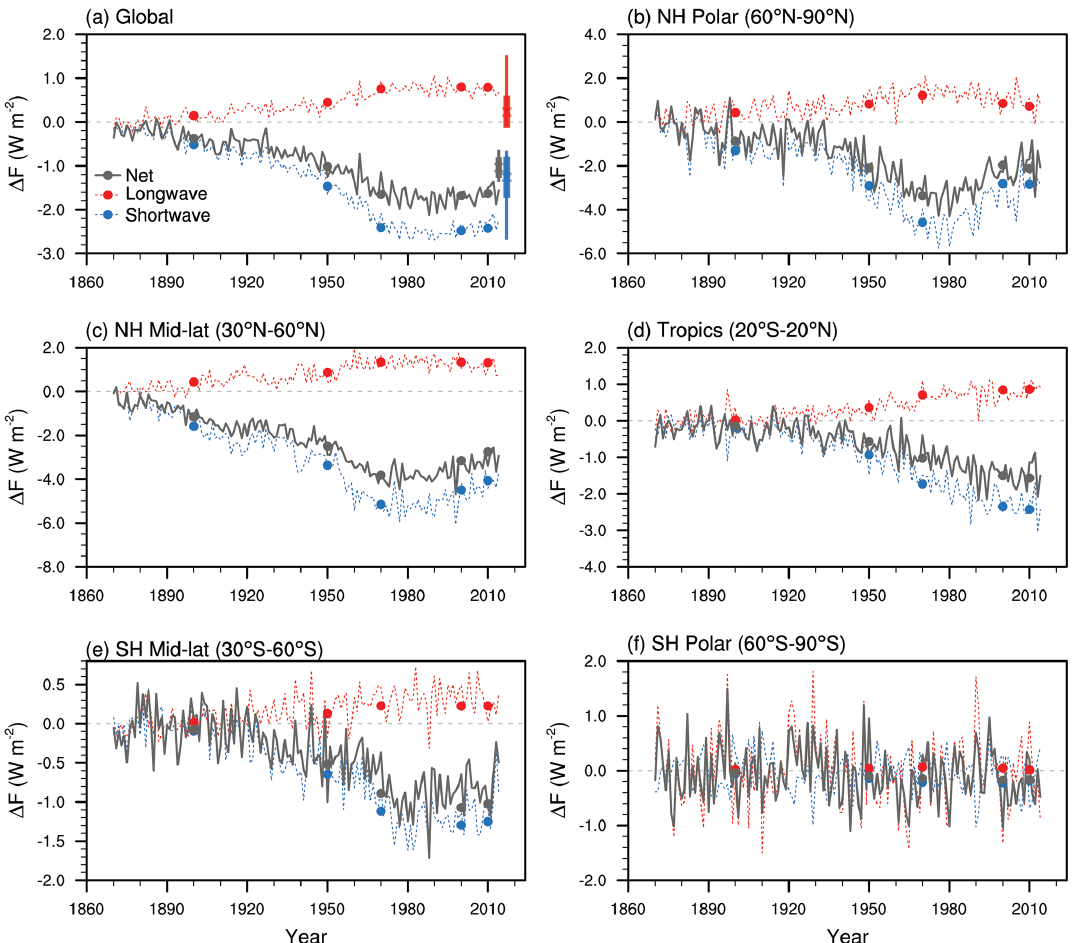
Figure 4. Temporal variations of global and annual mean ERF aer (Wm − 2 ) derived from the differences between simulations with transient and pre-industrial aerosol emissions. Solid lines indicate net ERF aer , and dotted lines indicate the shortwave (blue) and longwave (red) components. Dots indicate results from the short nudged simulations. The cross and the thick and thin vertical bars show the mean, standard deviations, and max–min (cid:49) F estimated by CMIP6 RFMIP models (Smith et al., 2020). See Sect. 3.2 for details.